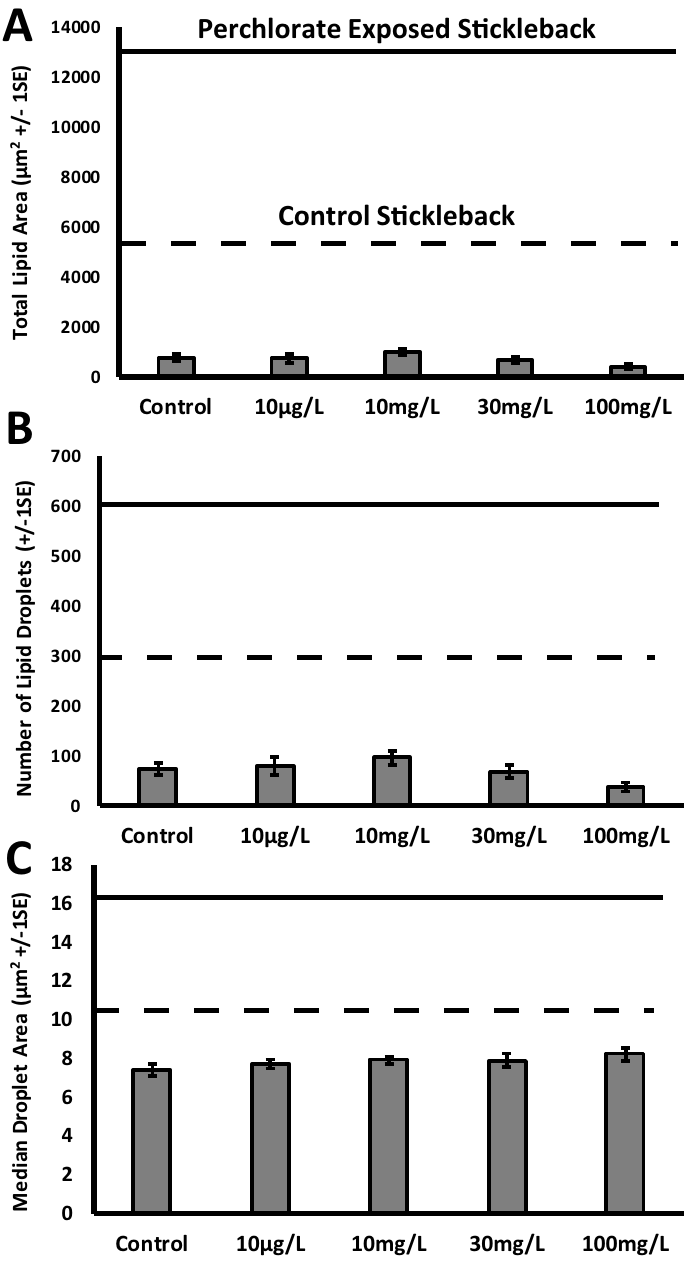
Fig 5. Comparison of the control liver (dashed line) and perchlorate exposed liver (solid line) of threespine stickleback to zebrafish liver morphology (grey bars). Stickleback data are derived from Minicozzi et. al. [45]. Perchlorate exposed line is an average value derived from treatment conditions in which stickleback were